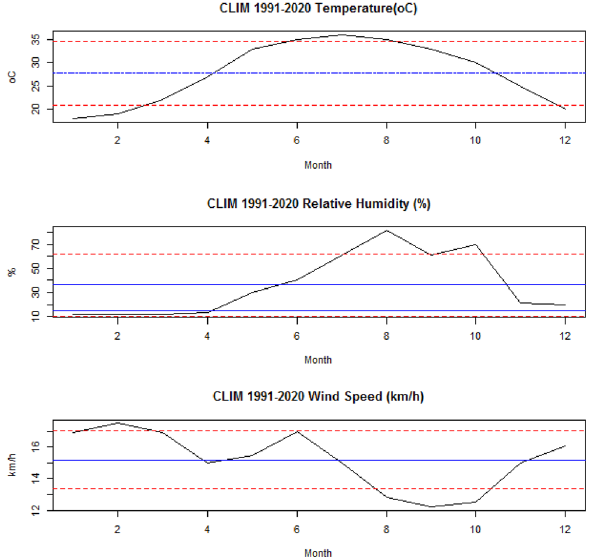
Fig. 1 The Doha Metropolitan Region current climatology, 1991– 2020. The blue line is the ensemble average and the red dashed line is the standard deviation interval (mean centered range— upper level plus the standard deviation and lower level minus the standard deviation)